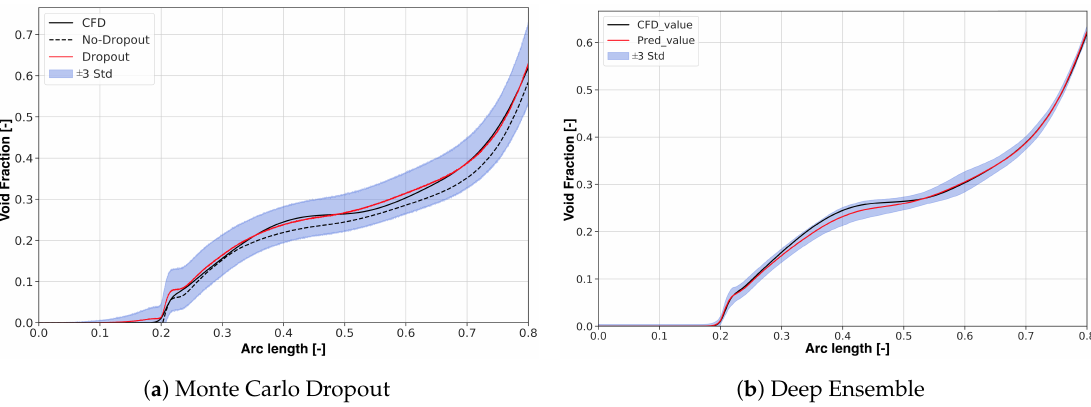
Figure 10. Void Fraction profile along arc length for extreme extrapolation dataset using Monte Carlo and Deep Ensemble models at q (cid:48)(cid:48) = 40,000 Wm − 2 and u = 0.2 ms − 1